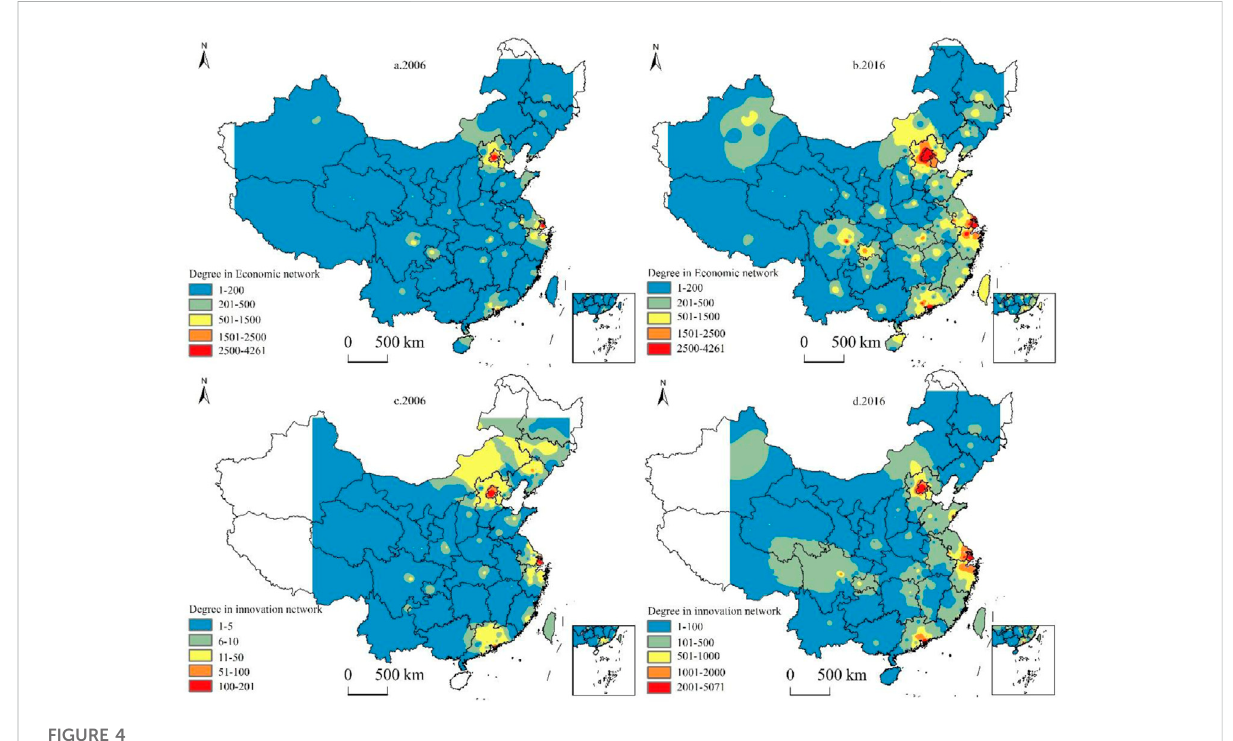
FIGURE 4 Interpolation of cities ’ degree in the economic network and innovation